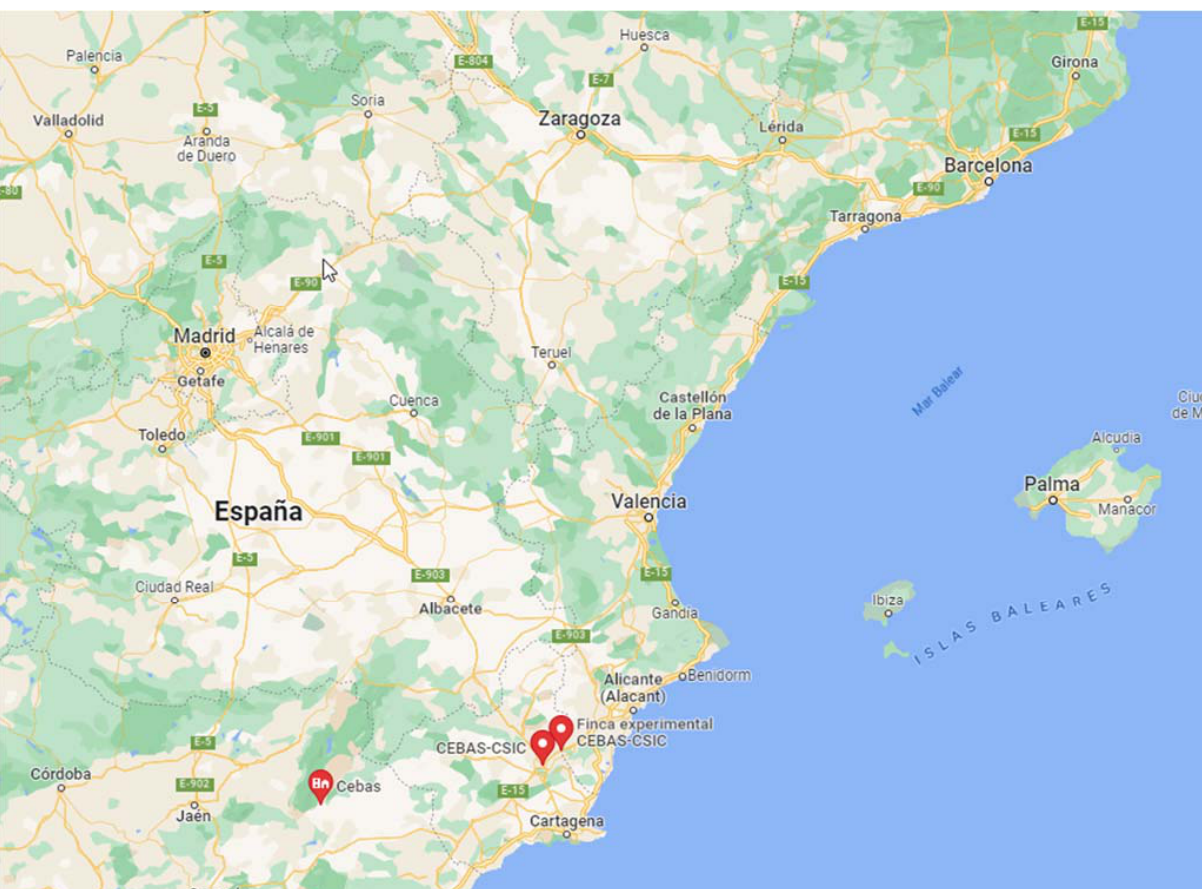
Figure A1. Location of the field trial in CEBAS-CSIC experimental field at South-Eastern Spain